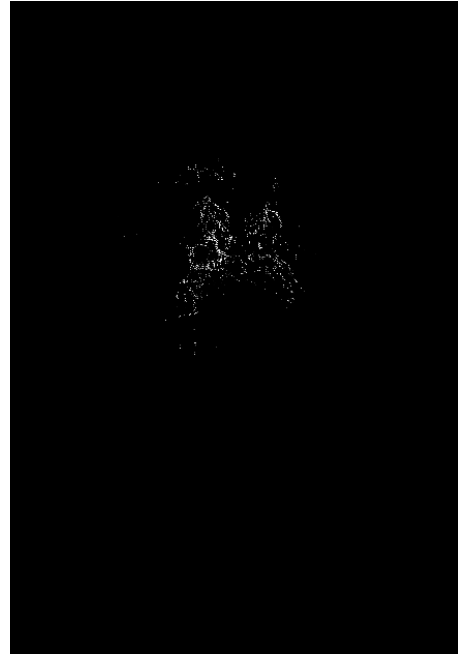
Figure 5. The extraction results of Ulva prolifera.